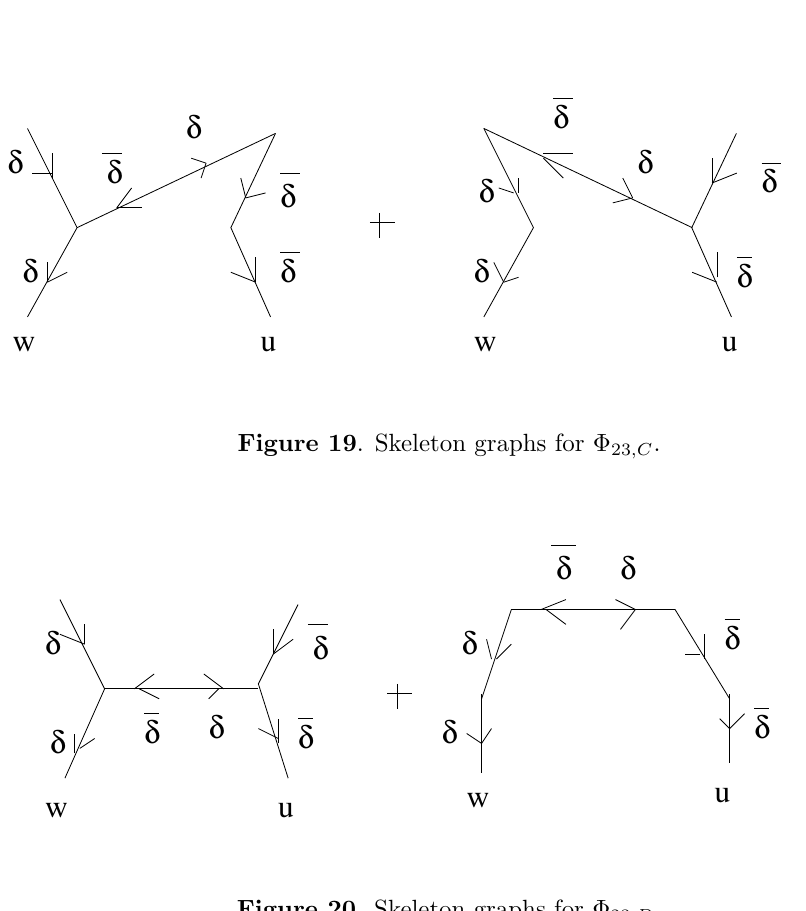
Figure 20 . Skeleton graphs for (cid:8) 23 ;D